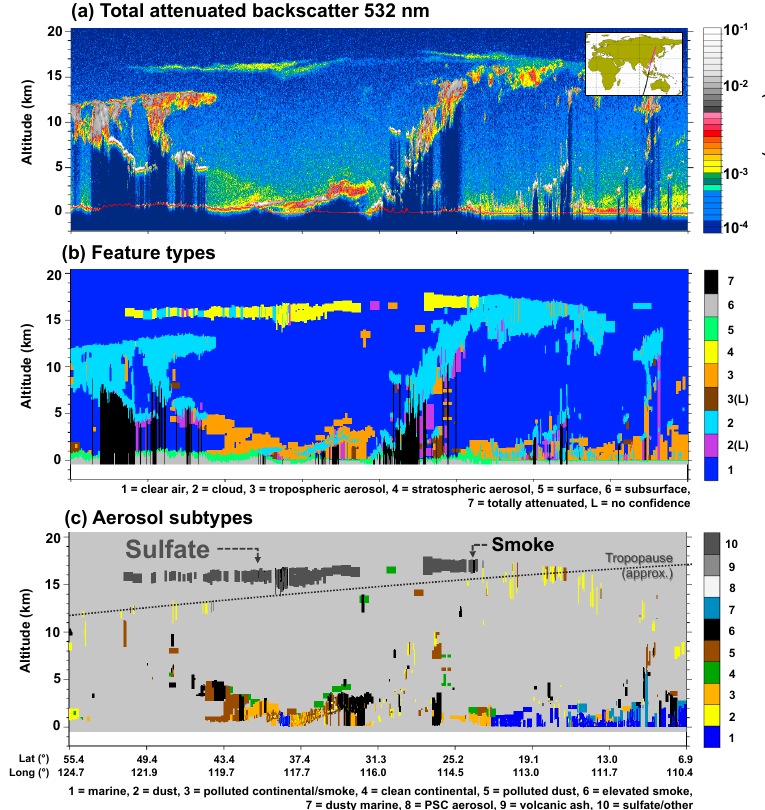
Figure 8. CALIOP observations of the Nabro volcano plume on 18 June 2011 between 18:13 and 18:26UTC. (a) To- tal attenuated backscatter at 532nm, (b) V4 feature type classifications, and (c) V4 aerosol subtypes; the dashed line indi- cates approximate location of the tropopause. The satellite ground track is indicated by the magenta section on the inset map in panel (a) . Additional imagery for this scene, including 532nm depolarization ratios and attenuated backscatter color ra- tios, can be found at https://www-calipso.larc.nasa.gov/products/lidar/browse_images/show_detail.php?s=production&v=V4-10&browse_ date=2011-06-18&orbit_time=18-13-27&page=1&granule_name=CAL_LID_L1-Standard-V4-10.2011-06-18T18-13-27ZN.hdf (last